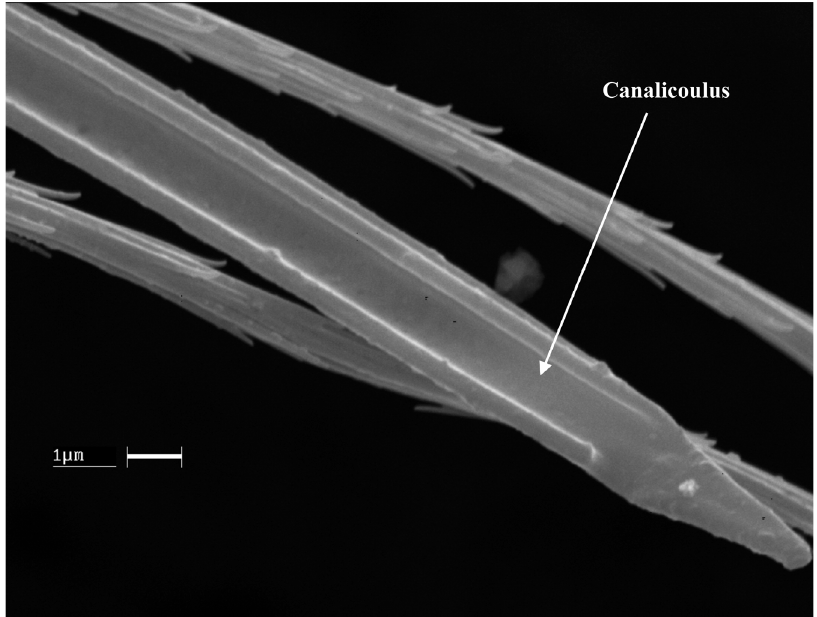
Fig. 2. Distal part of a cheli- ceral stylet of Tetranychus ur- ticae